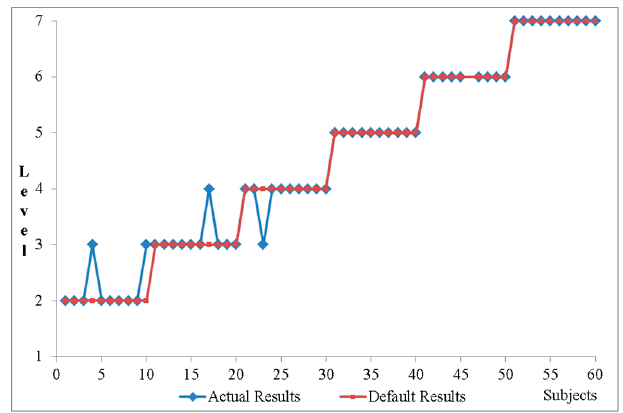
Figure 11. Default results comparison with actual results.